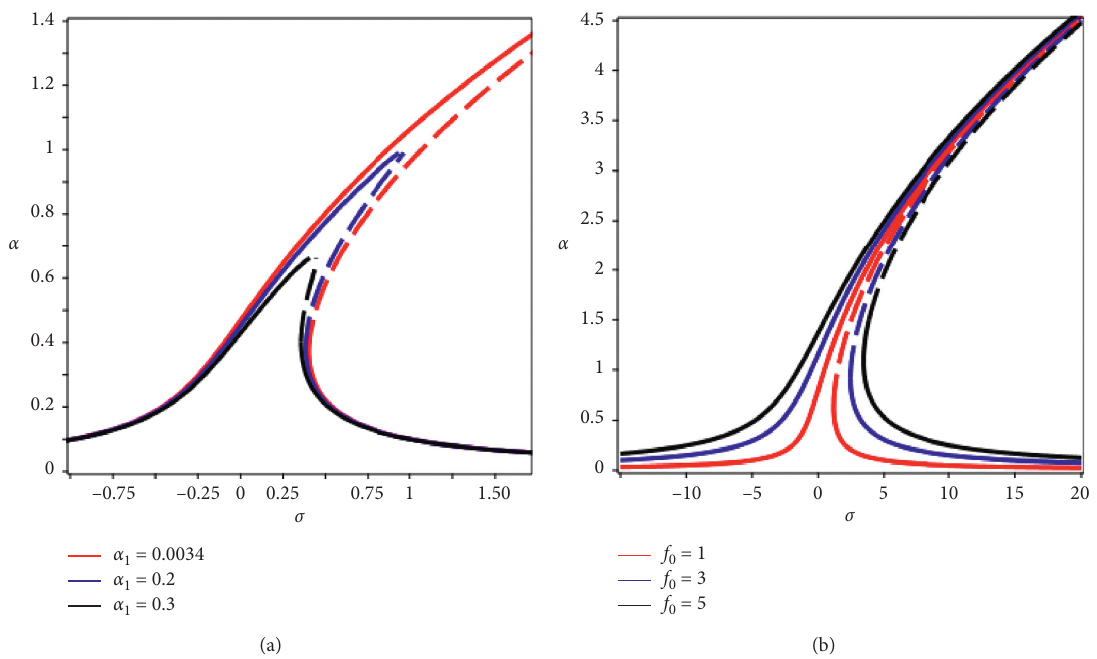
� 2 . 3919, and f � 0 . 2. (b) Ω ≈ 1, α � 0 . 0034, and α � 2 . 3919. Solid 2 0 1 2